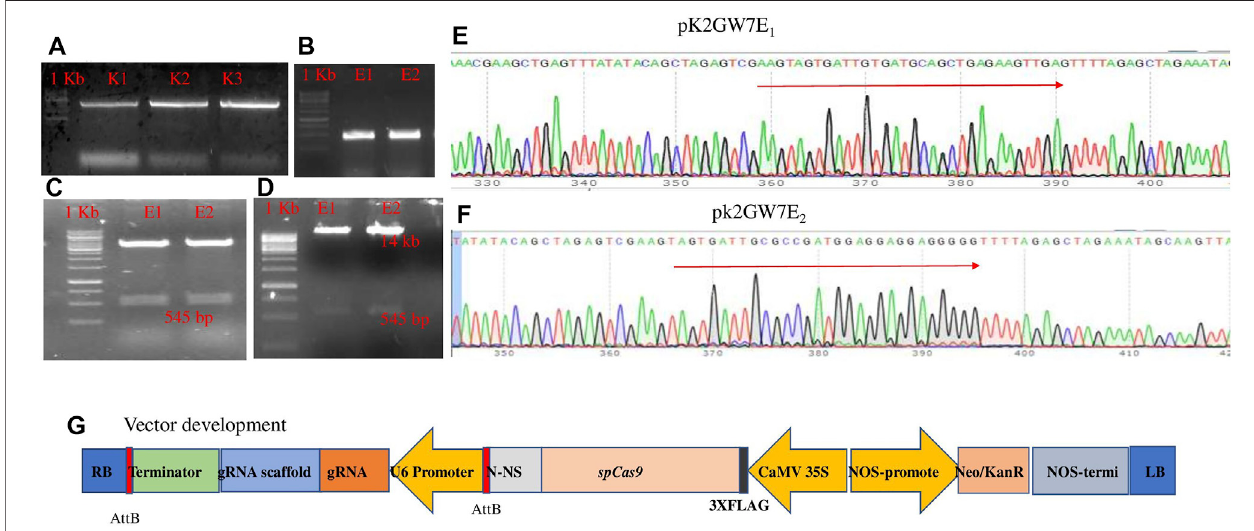
FIGURE1|(A) Ampli fi cation of eIF4E gene and the4.5-kbfragment; (B) ampli fi cation using thePCF/PCR primer set and the556-bp fragment; (C) con fi rmation of gRNA in each construct by restriction analysis with the Bbs1 site in p. chimera vector; (D) the gRNA cassette con fi rmation in the Pk2GW7- Cas9 vector (uncropped gel pictures with +ve and − ve controls are present in Supplementary Figures S4A – C ); (E) pK2GW7E 1; ; (F) pk2GW7E 2 through Sanger sequence con fi rmation of the gRNA cassette; (G) schematic diagram of the construct used for genome editing. All gRNAs targeting eIF4E were cloned in the same manner. The construct was expressing gRNA under the At-U6 promoter. The plant codon-optimized Cas9 was expressed under the 35S CaMV